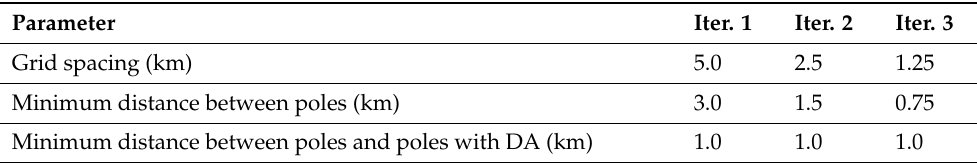
Table 4. Iteration parameters for grid and poles